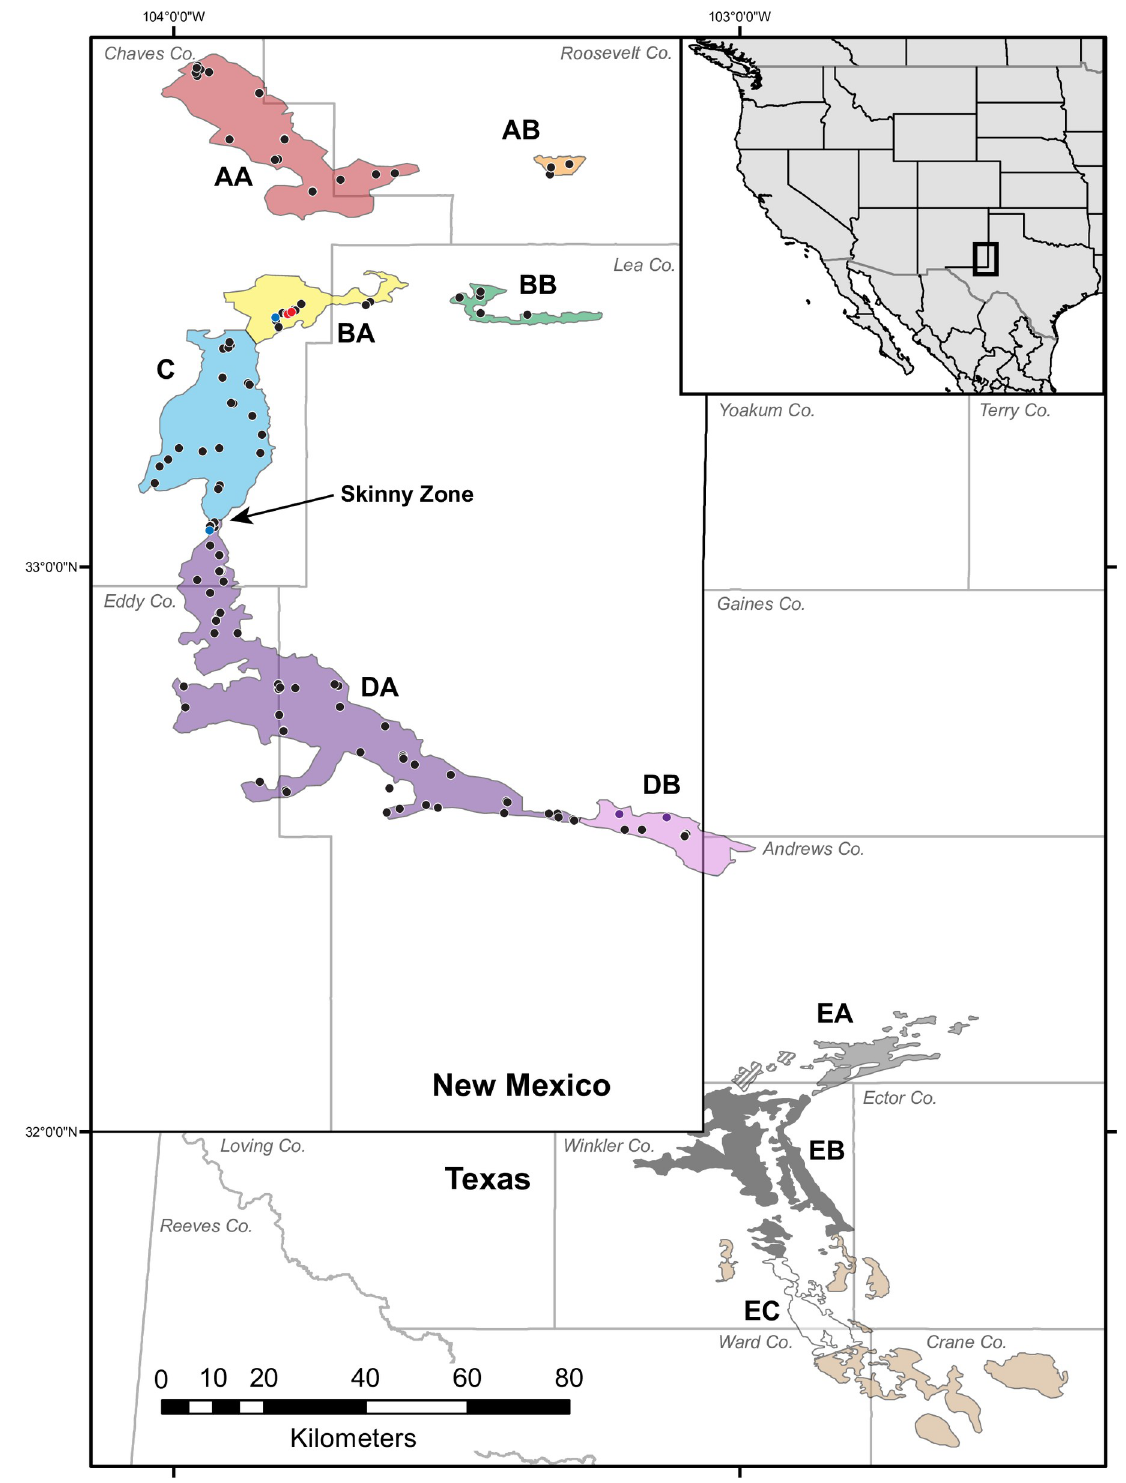
Fig 1. Suitable shinnery oak-sand dune habitat for S . arenicolus (from [22]) and sampling localities for this study. Black and gray lines indicate state and county boundaries, respectively. Shaded areas delineate potentially suitable habitat for S . arenicolus with colored portions of the landscape corresponding to the phylogroups and geographic regions referred to in the text. Striped areas have not been surveyed, but contain suitable habitat. Brown indicates areas with potentially suitable habitat where S . arenicolus has not been found. One